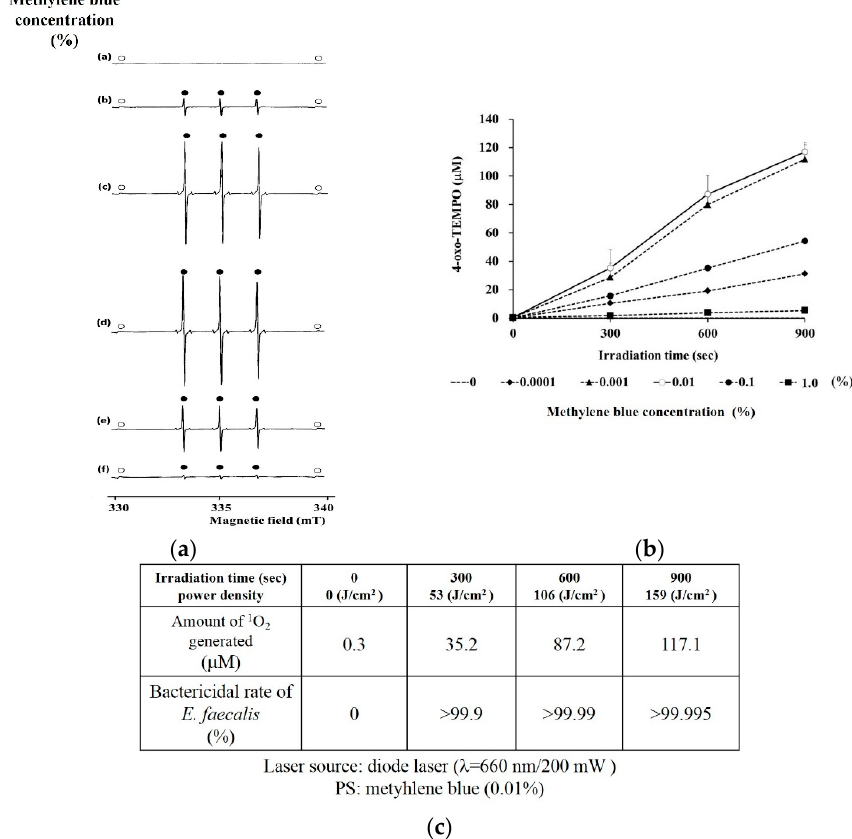
Figure 5. Relationship between the appropriate PS concentration and bactericidal effects in terms of ROS generation. ( a ) Measurement of ROS using an electron spin resonance (ESR) spin-trapping method. Typical ESR signal of 4-oxo-TEMPO generated by a diode laser ( λ = 660 nm) with irradiation for each MB concentration (a: 0; b: 0.0001%; c: 0.001%; d: 0.01%; e: 0.1%; f: 1.0%). The 4-oxo-TEMP was used to trap the generated 1 O 2 . The 4-oxo-TEMP traps 1 O 2 and converts it to 4-oxo-TEMPO. The white and black circles indicate the Mn 2+ marker and the nitroxide radical, respectively. ( b ) Diode laser irradiation time and amount of 1 O 2 generated. 1 O 2 occurred at all MB concentrations in a laser irradiation time-dependent manner. The largest amount of 1 O 2 generated was at 0.01% MB. ( c ) Relationship between the amount of 1 O 2 generated and the bactericidal effect of Enterococcus faecalis . Adapted from Ref. [55].